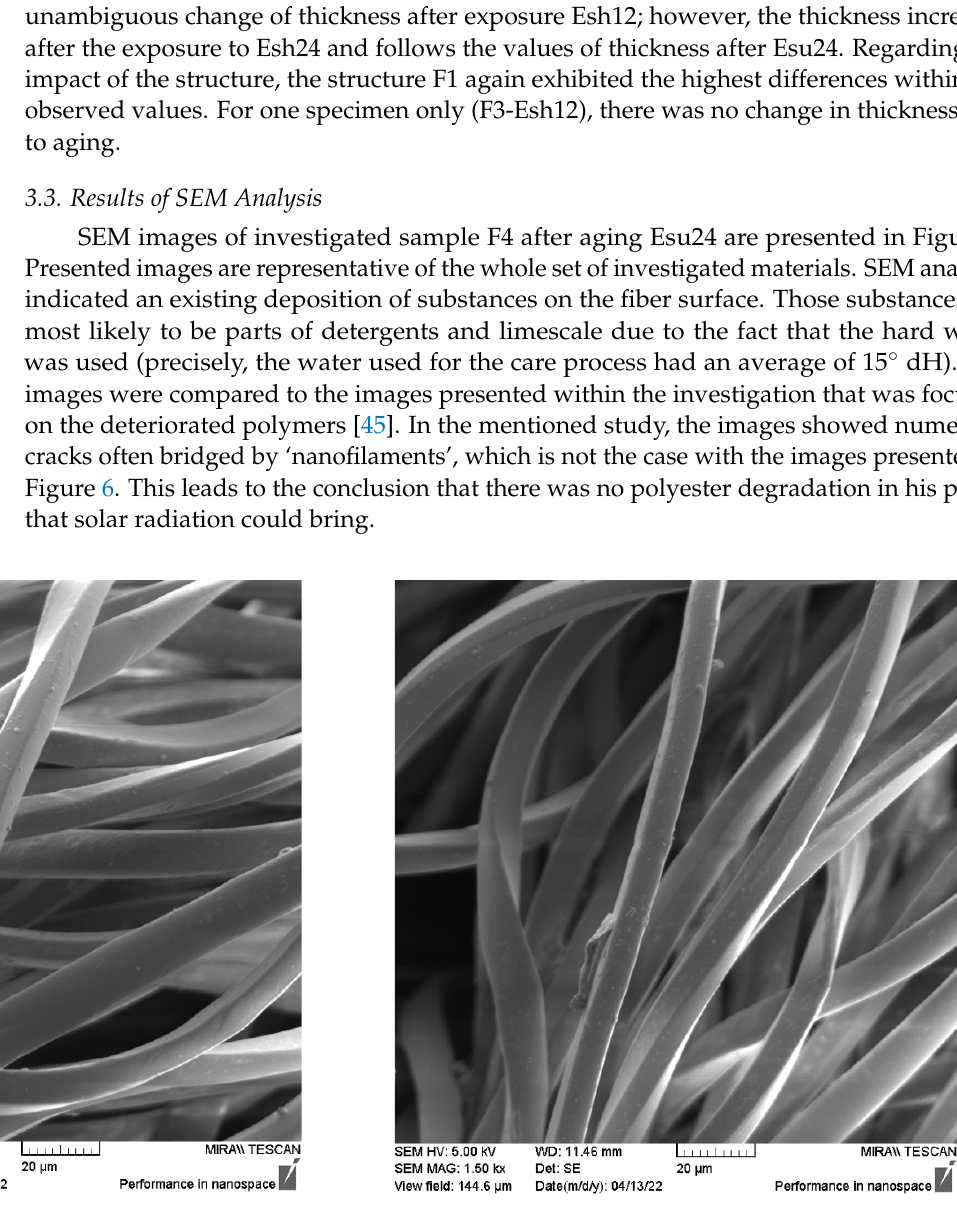
Figure 6. SEM images of F4-Esu24 under magnification of 1.50 kx.